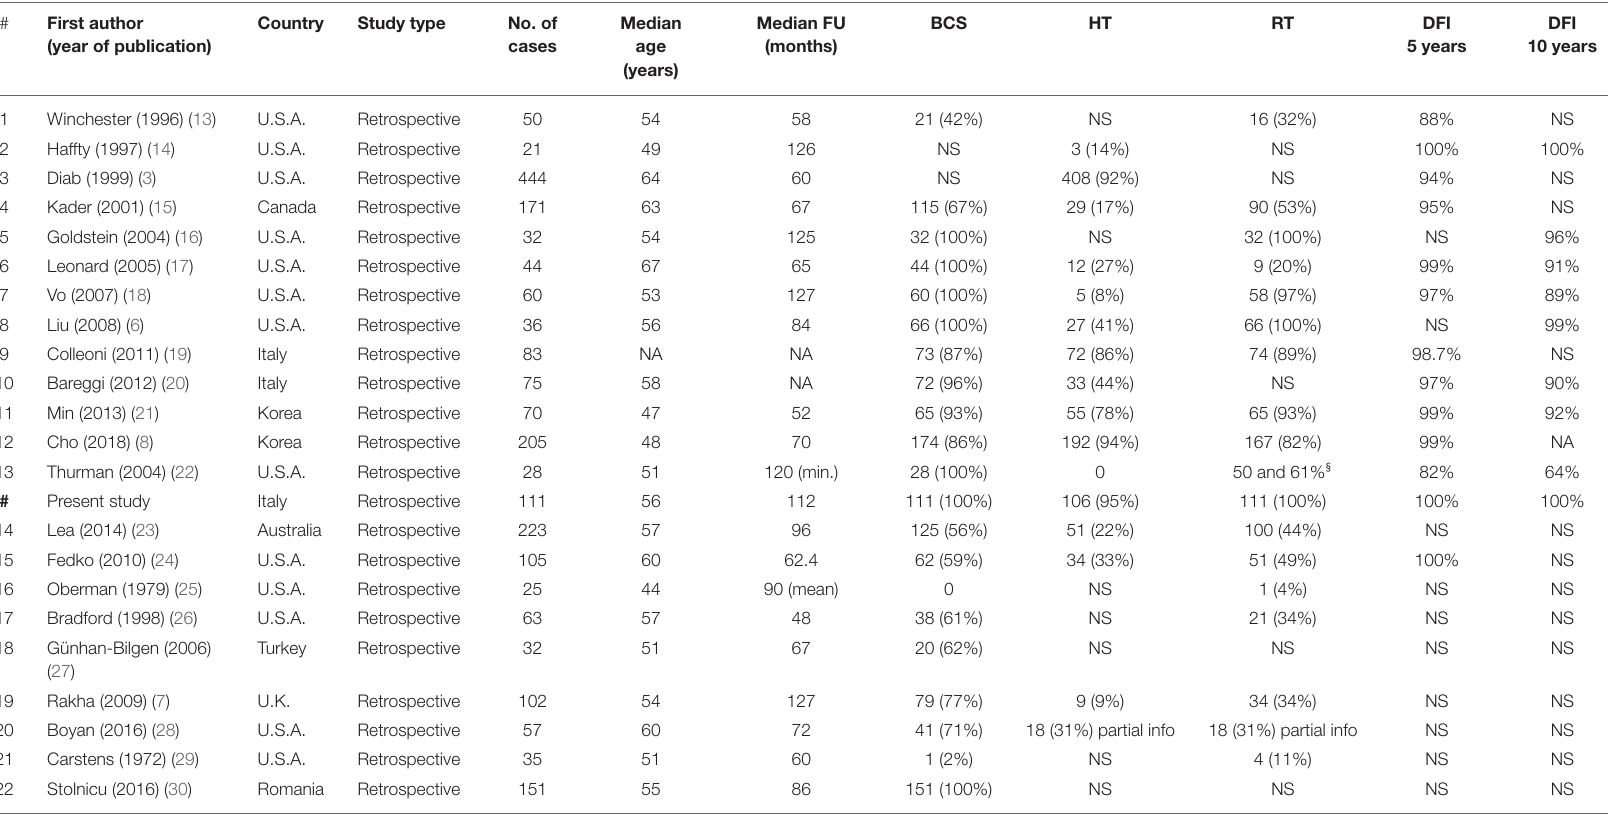
TABLE 3 | Characteristics of the studies considered in the